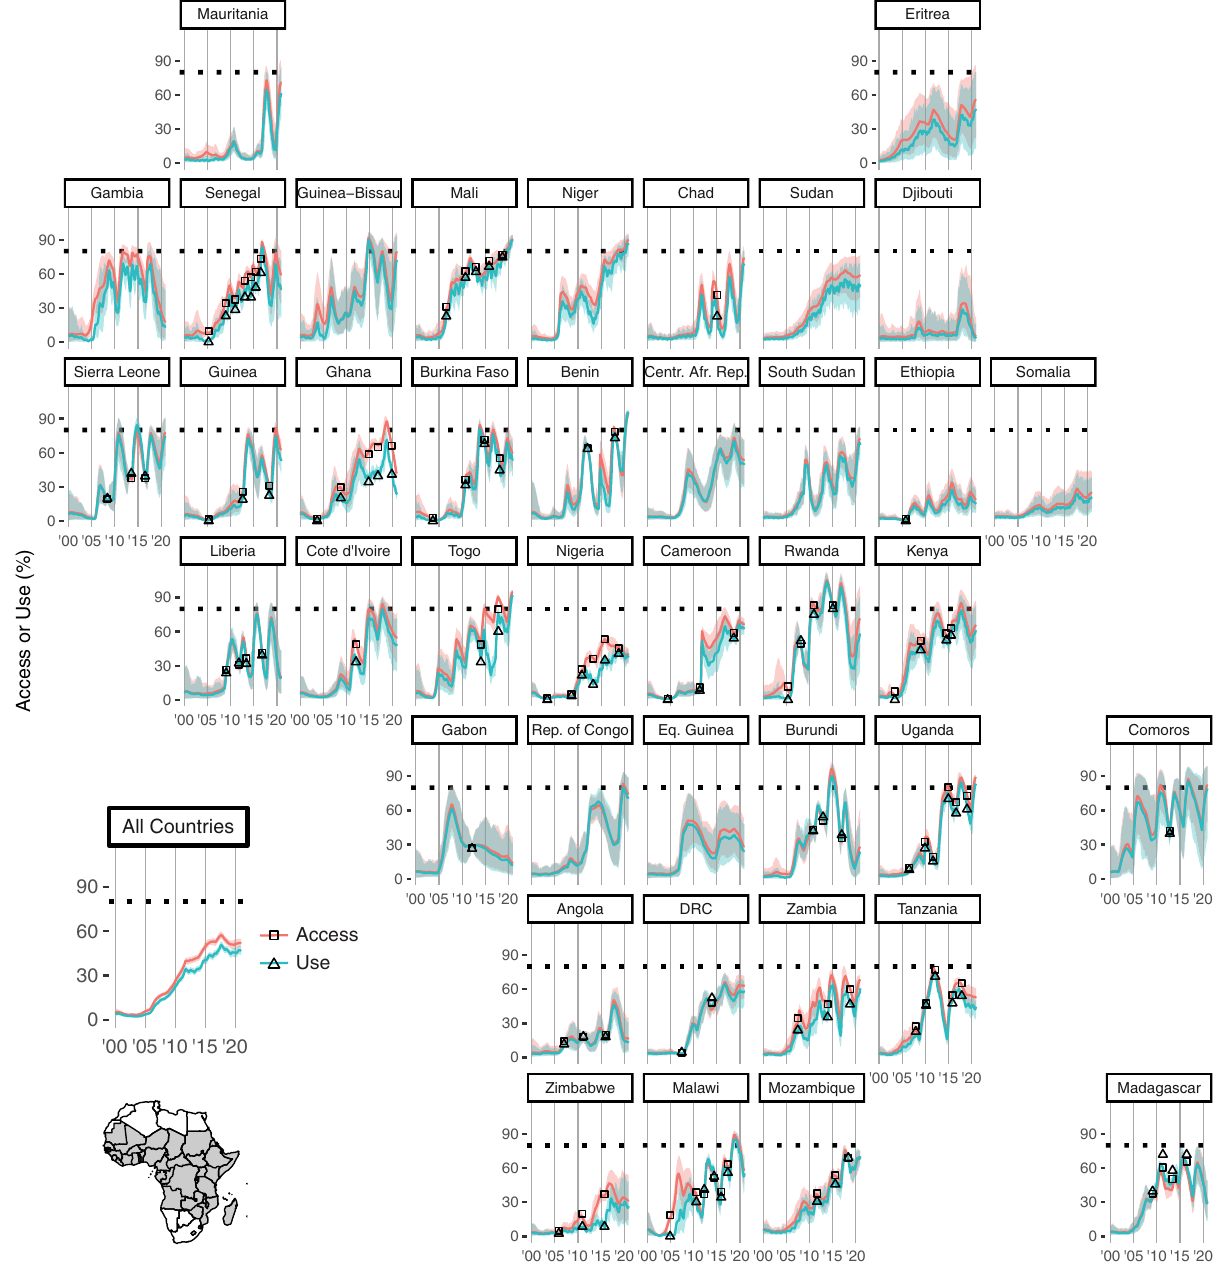
Fig. 2 National-level insecticide-treated net access and use time series. National-level mean estimates of access (red curves) and use (blue curves) among the population at risk are shown at a monthly time scale. The dotted lime indicates 80%, commonly used as a benchmark for universal coverage. Squares and triangles indicate nationally representative survey values of access and use, respectively. Only surveys that include spatial information are shown here; surveys included in the stock-and- fl ow model but not the geospatial model can be found in Supplementary Table 1.l. Shaded areas represent 95% conr fi dence intervals. Spikes in coverage indicate mass net distribution campaigns, with coverage subsequently declining due to attrition. The seasonality of use is evident in the curvature of the blue lines. Centr. Afr. Rep. Central African Republic, Rep. of Congo Republic of Congo, DRC Democratic Republic of the